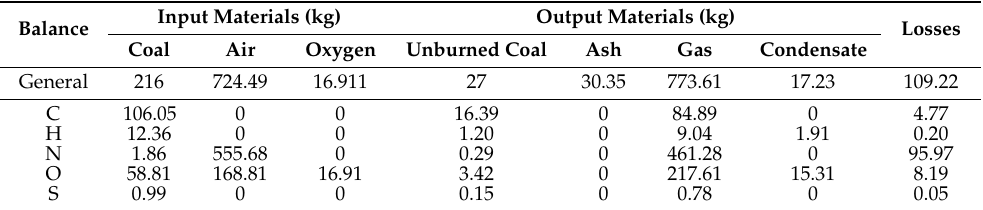
Table 3. The general and atomic balance values obtained from the second experiment calculations.